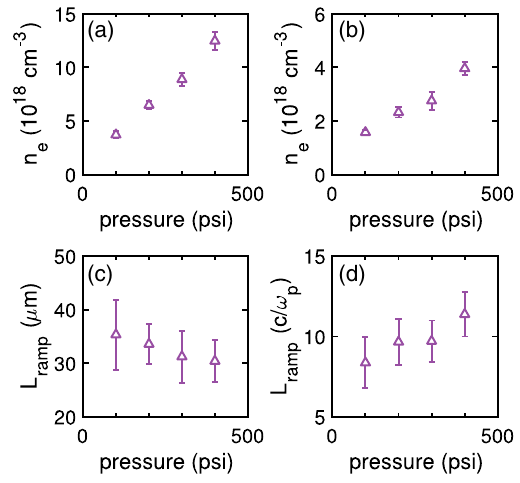
FIG. 2. Characteristics of the down ramp as a function of the backing pressure. (a) Upper shelf density of the down ramp. (b) Lower shelf density of the down ramp. (c) Ramp length in real units. (d) Ramp length in normalized units. Each data point is an average, and the error bar represents the standard deviation of 20 shots.